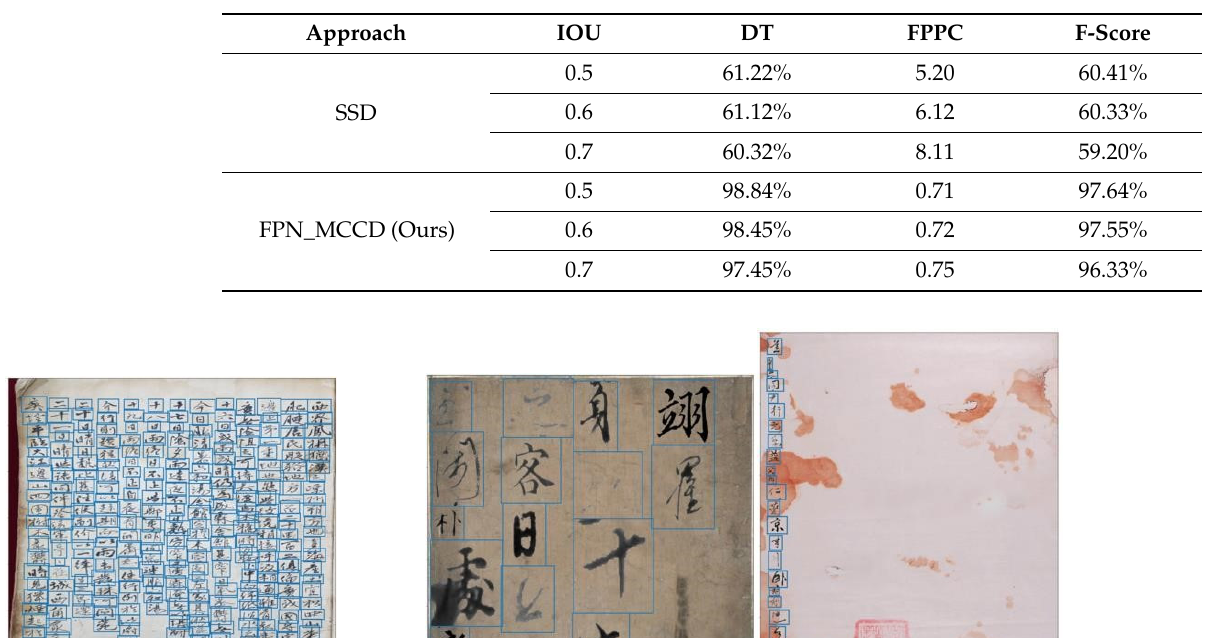
Table 2. Comparison between FAN-MCCD, SSD, and other algorithms with different values of IOUs in terms of detection rate (DT), false positive per character (FPPC), and F-score.